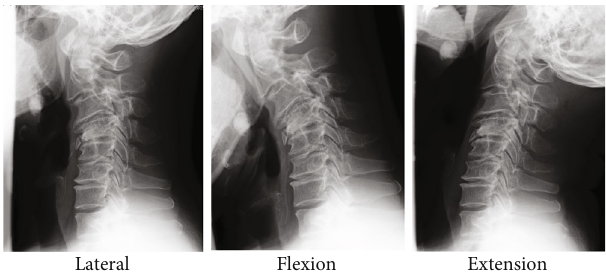
Figure 4: Preoperative MRI images. (a) Preoperative MRI images showed spinal cord compression at C2-3 level with spinal edema. (b) Axial MRI images of C2-3 right facet joint indicate an articular edema.